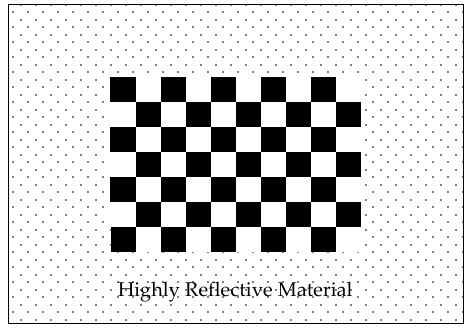
Figure 1. Autonomous identification calibration board.